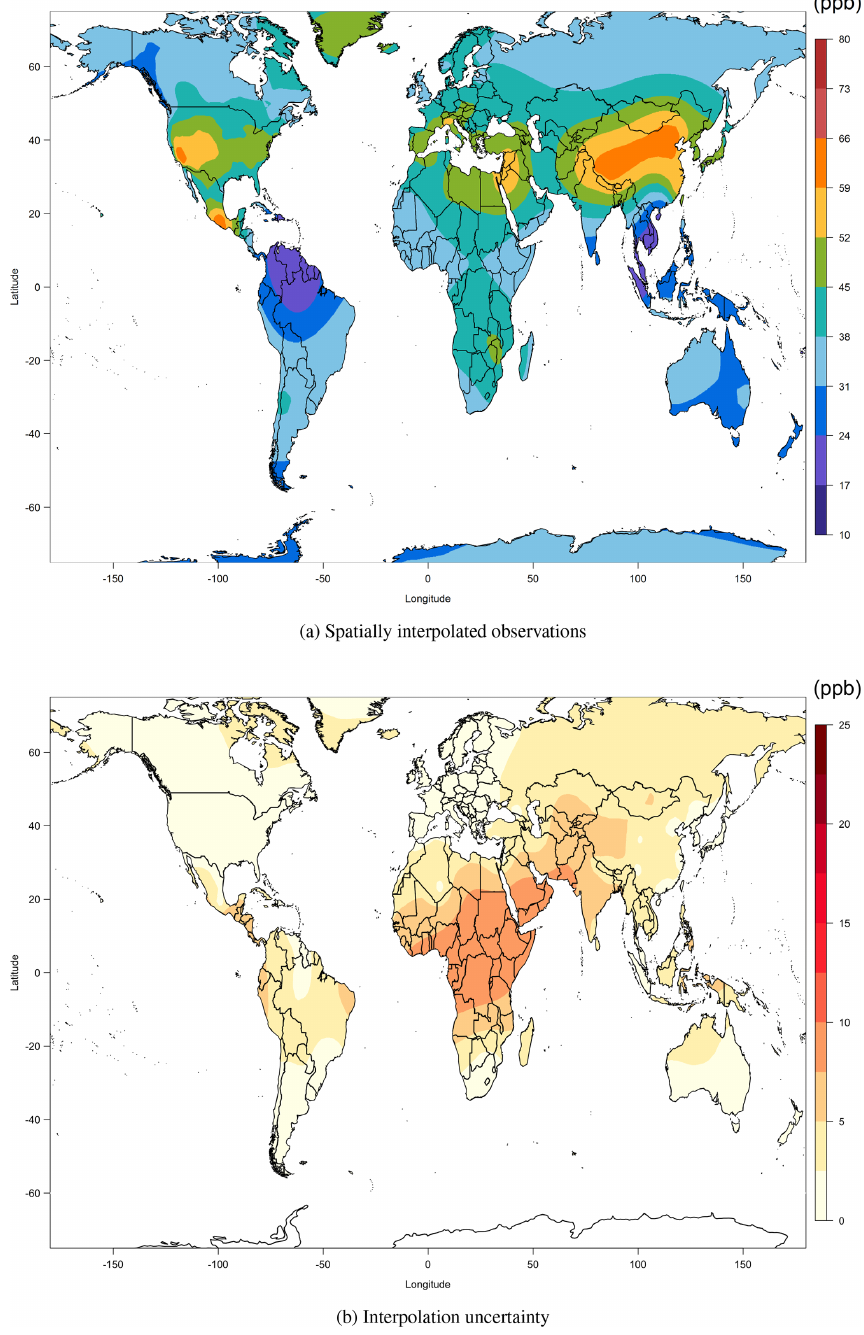
Figure 2. Estimates of spatially interpolated surface ozone distribution and associated uncertainty (half width of the 95% credible interval from each